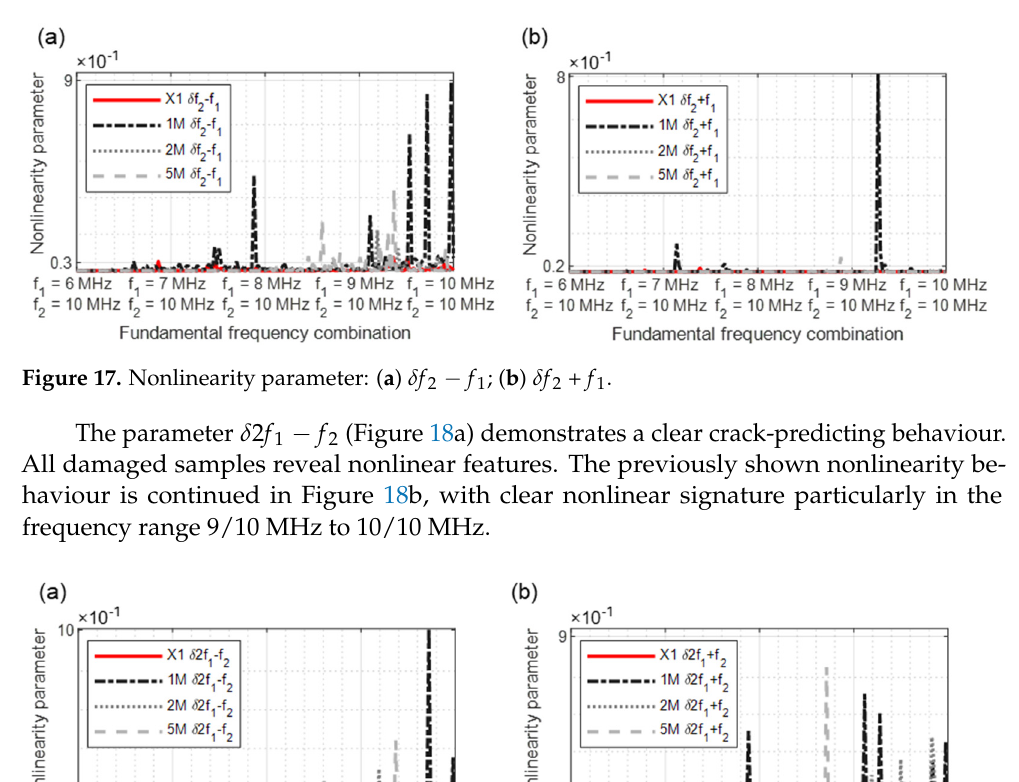
Figure 16. Nonlinearity parameter: ( a ) δ 3f 1 ; ( b ) δ 3f 2 .